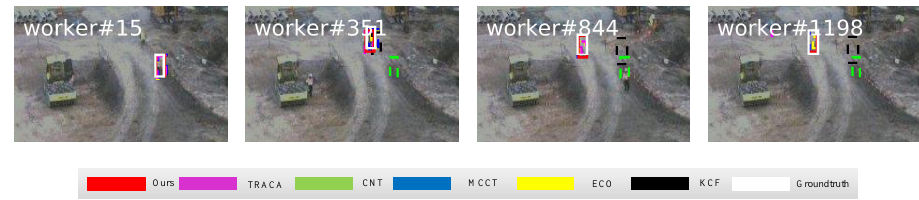
Figure 26. Qualitative results on the worker sequence in color.